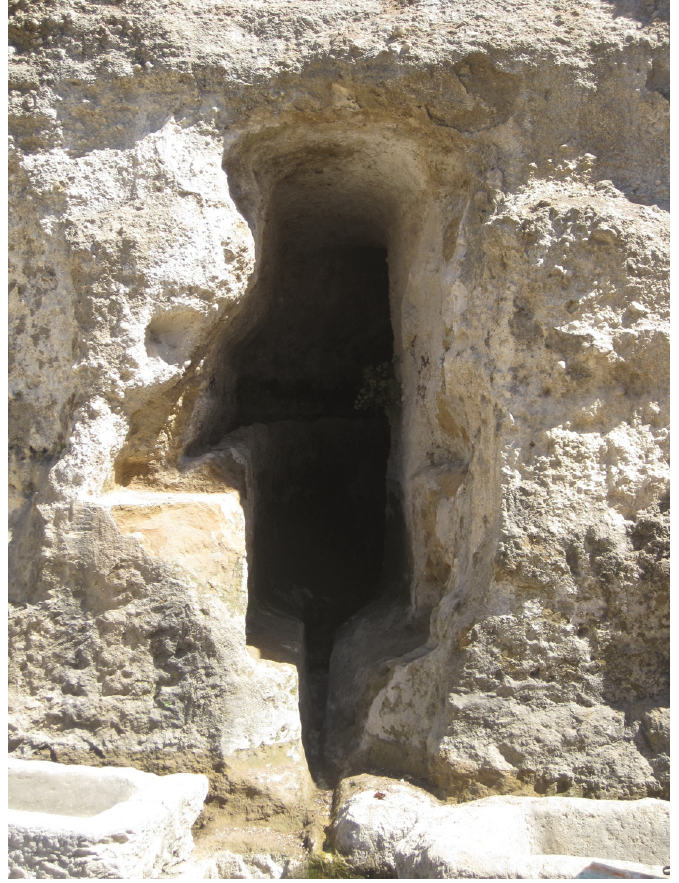
Figure 6. Exit of the tunnel; and channel of aqueduct 1 [20].